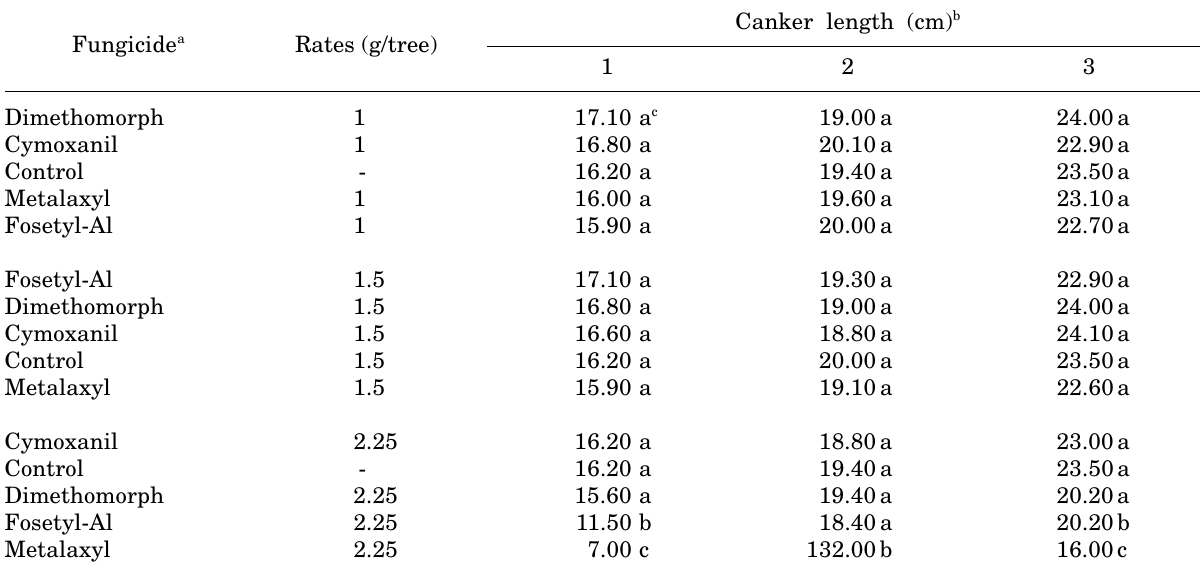
Table 4. Canker length (cm) of 2-year-old KID I peach seedlings after inoculation with Phytophthora citrophthora . Inoculated plants were soil-drenched with metalaxyl, fosetyl-Al, dimethomorph, and cymoxanil one, two and three weeks after the inoculations.